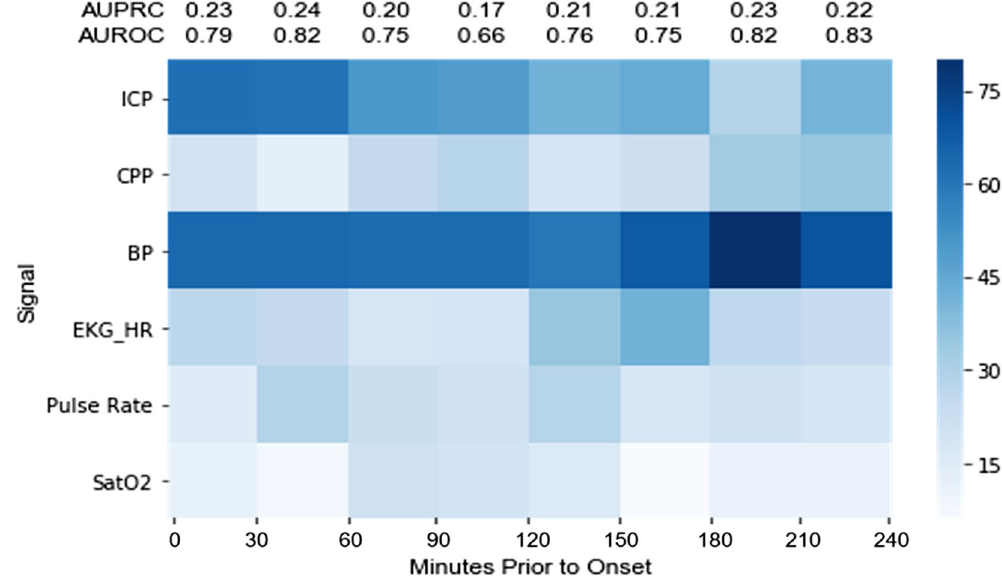
Figure 5. Heat map of most important features across 10 training–testing iterations in every 30 min analysis window. 200 features in each column are categorized by physiologic signal. Darker blue means a greater number of features derived from the physiologic